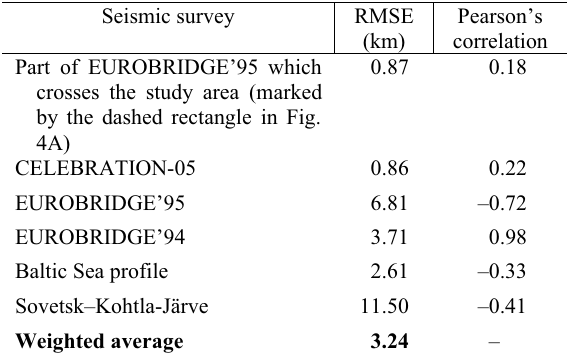
Table 3. Validation results of the best performing Moho